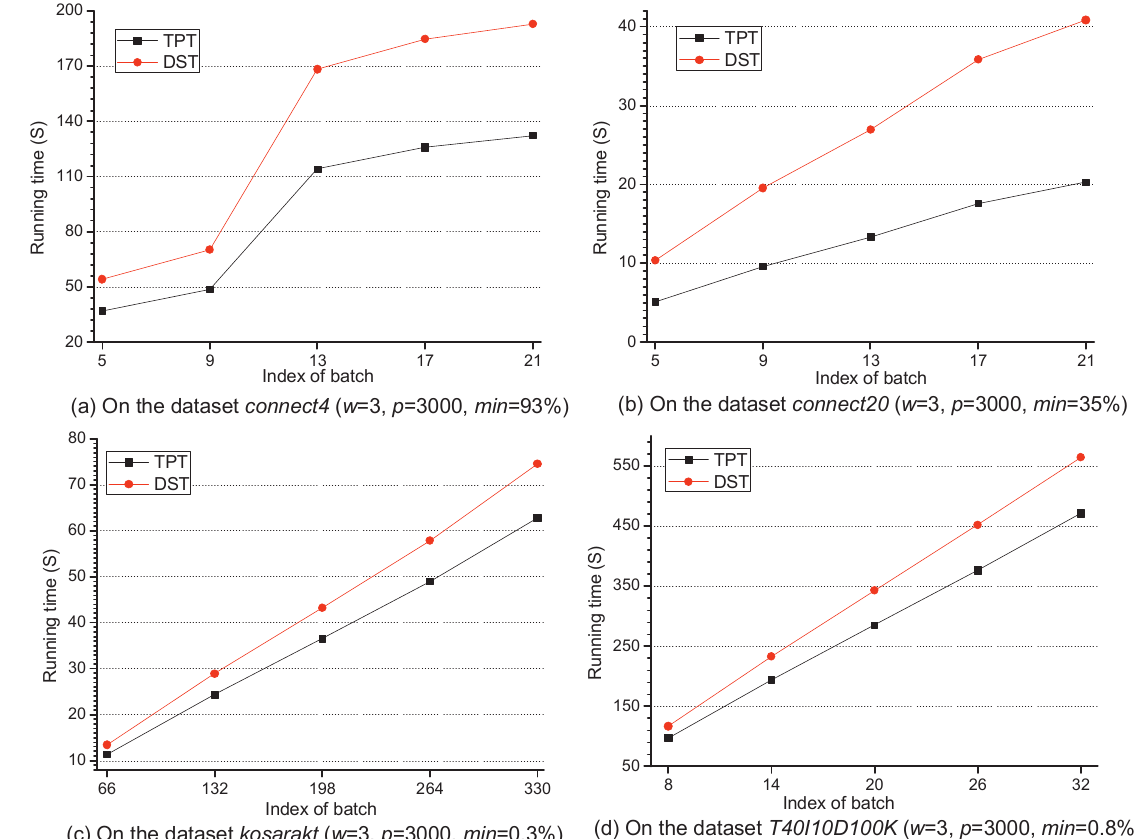
Fig. 8. Evaluation on accumulated